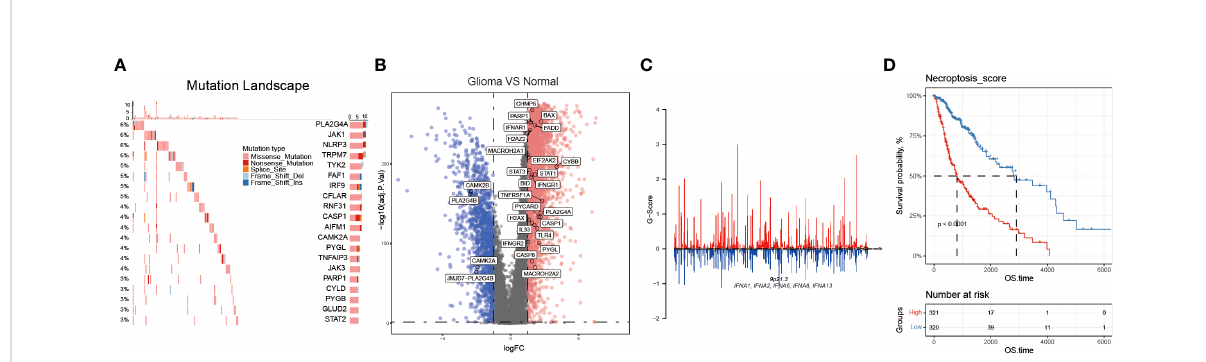
FIGURE 2 The necroptosis pathway is dysregulated in glioma. (A) NRGs mutational landscape. The more frequent mutations included missense and nonsense mutations, splice sites, deletions, and insertions. (B) Volcano plot showing some NRGs differentially expressed in glioma and normal brain tissues. (C) The CNV, gain, and loss of the NRGs and their distribution on human chromosomes. (D) Necroptosis score was calculated by using the GSVA method, and through the K-M curves, activated necroptosis was found associated with poor prognosis (OS).